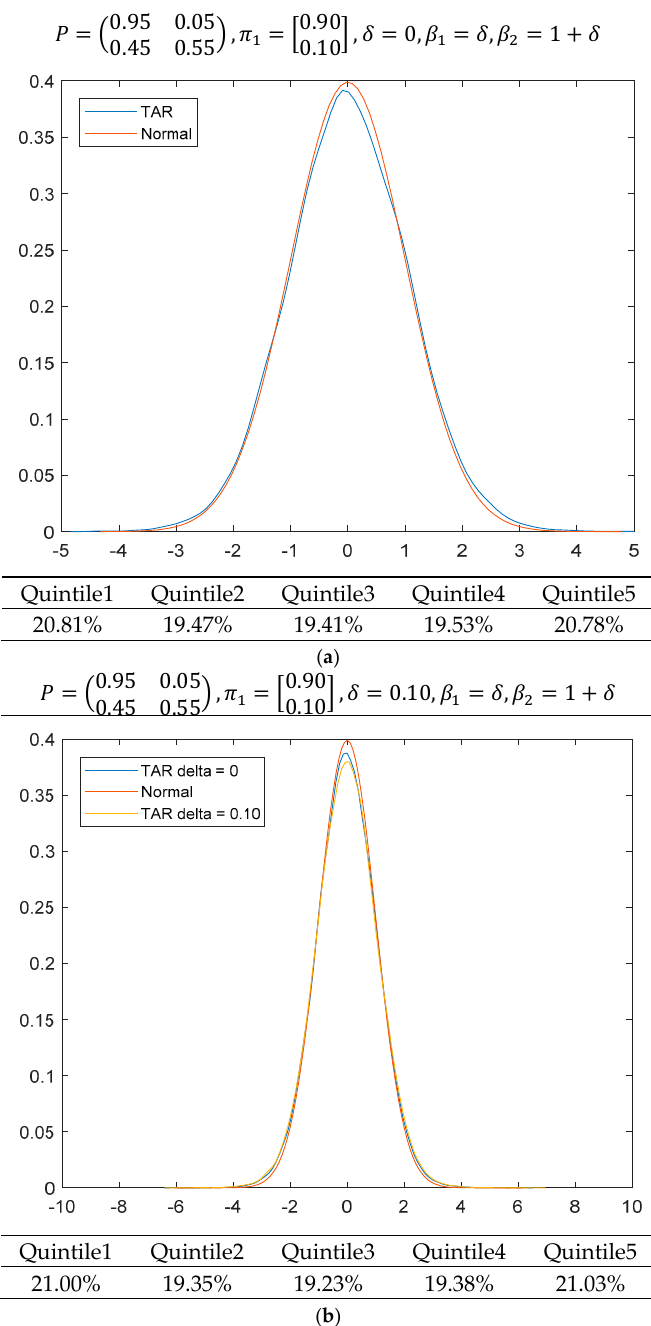
Figure 3. ( a ) Simulated Distributions for TAR(1) with 𝜋 (cid:2869) as the steady state vector and 𝛿 = 0 . ( b ) Simulated Distributions for TAR(1) with 𝜋 (cid:2869) as the steady state vector and 𝛿 = 0.10 .